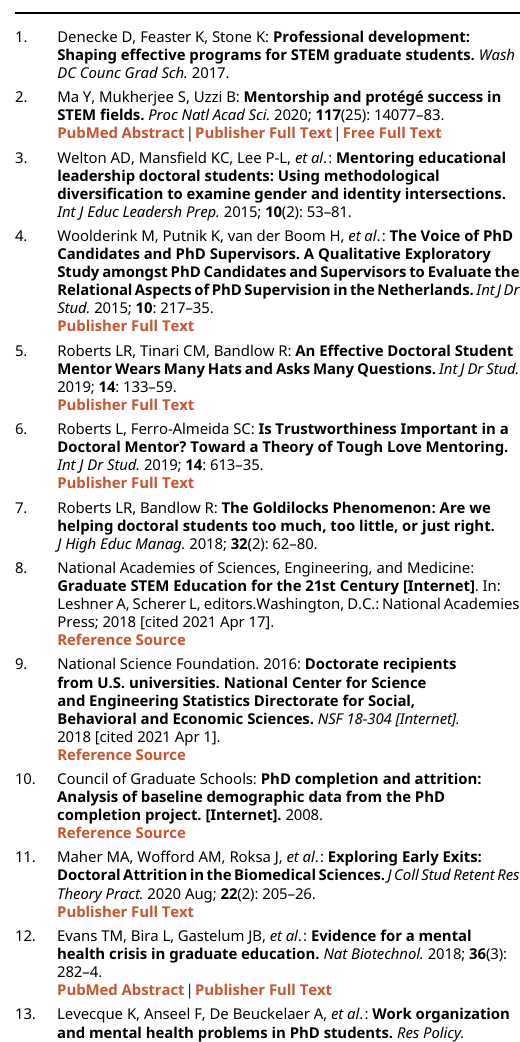
Figshare: Survey Questions - Modeling individual development plans, mentoring support, and career preparedness relationships among Ph.D. trainees in the life sciences. https://doi.org/10.6084/m9.figshare.14893182.v1. 27 This project contains the following extended data: the questionnaire for this